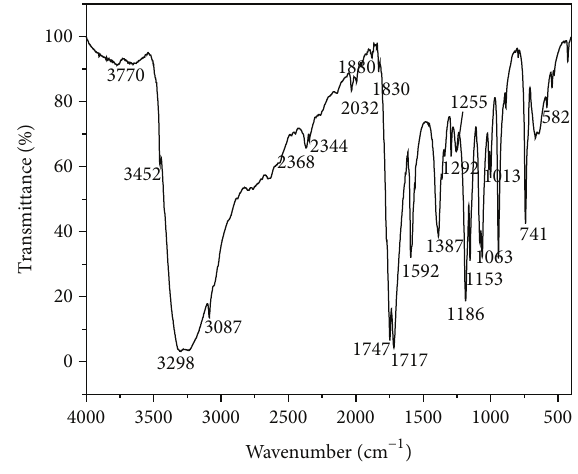
doped ninhydrin. 2+